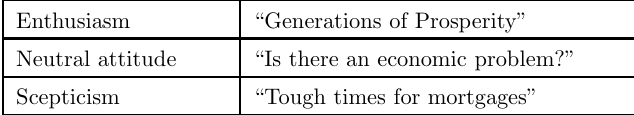
Examples of headlines in the US press Enthusiasm “Generations of Prosperity” Neutral